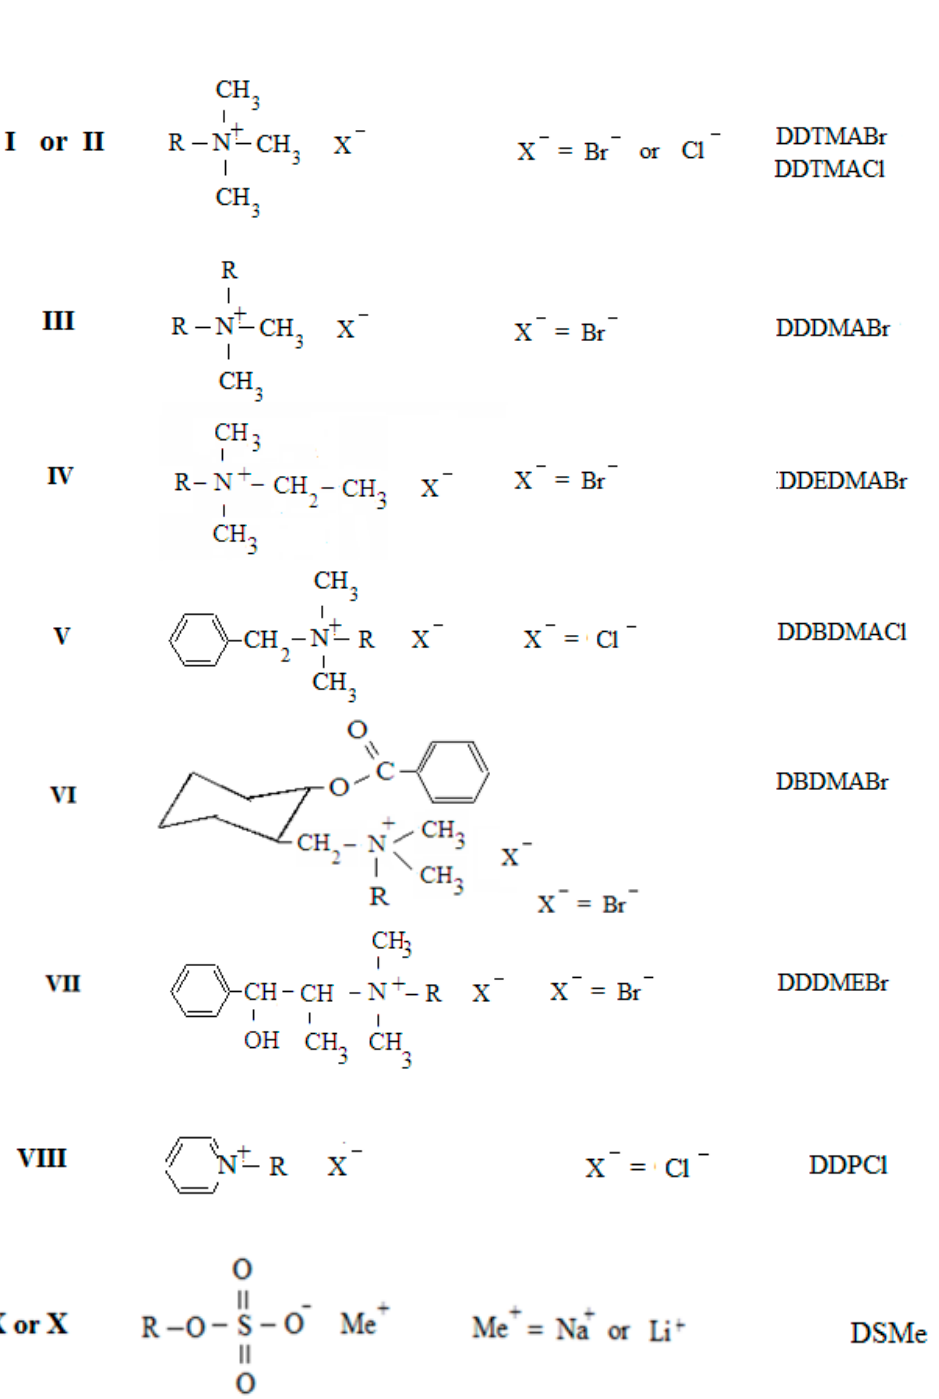
Figure 1. Structural formula of studied compounds. R is the dodecyl chain [CH 3 -(CH 2 ) 11 -].